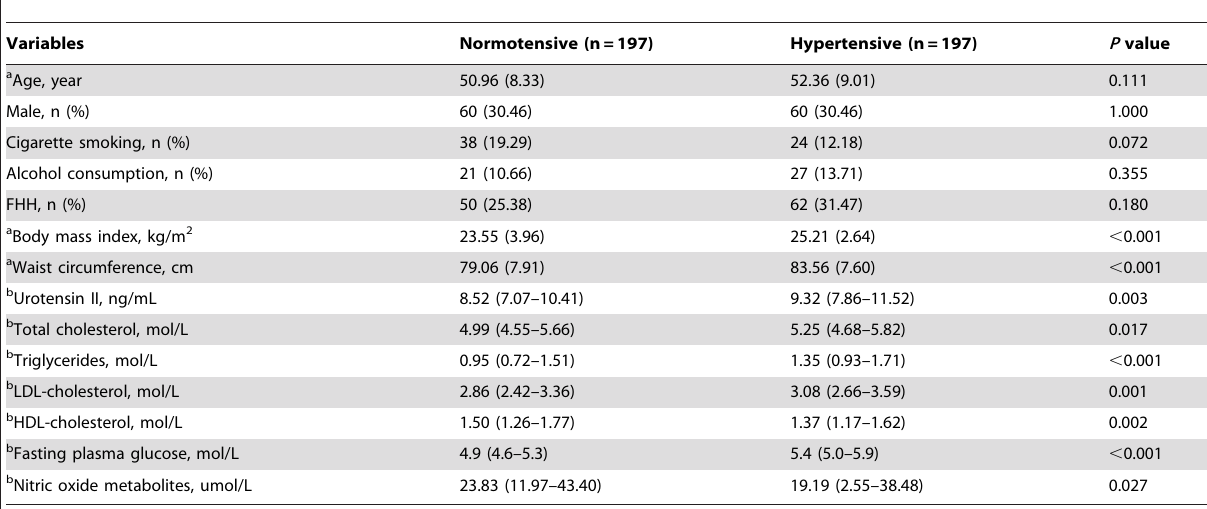
Table 1. Baseline characteristics of hypertensive cases and normotensive controls.